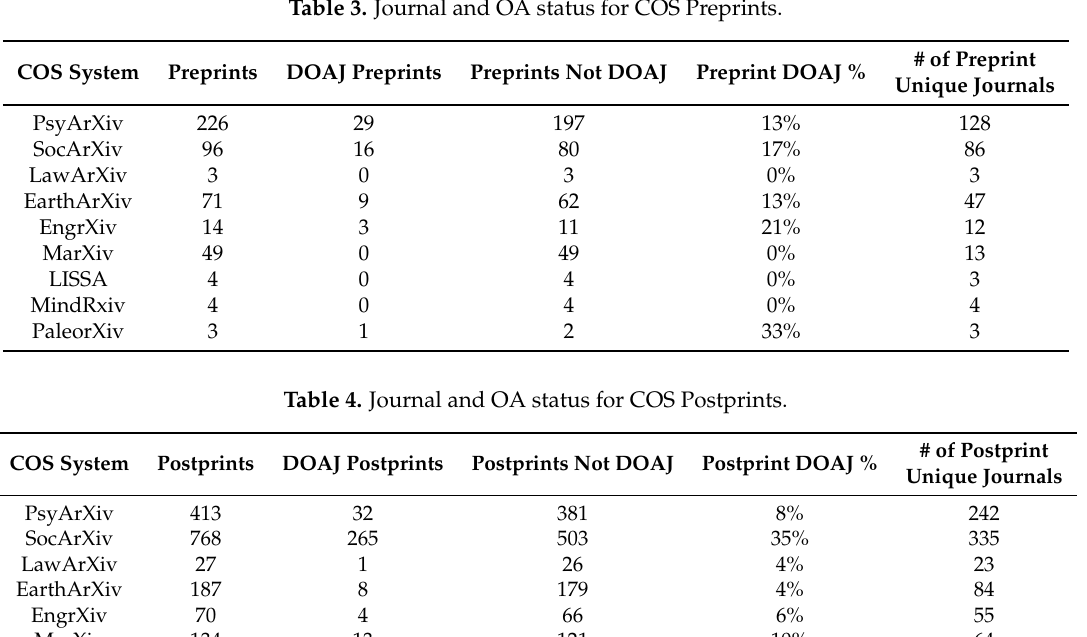
Table 3. Journal and OA status for COS Preprints.